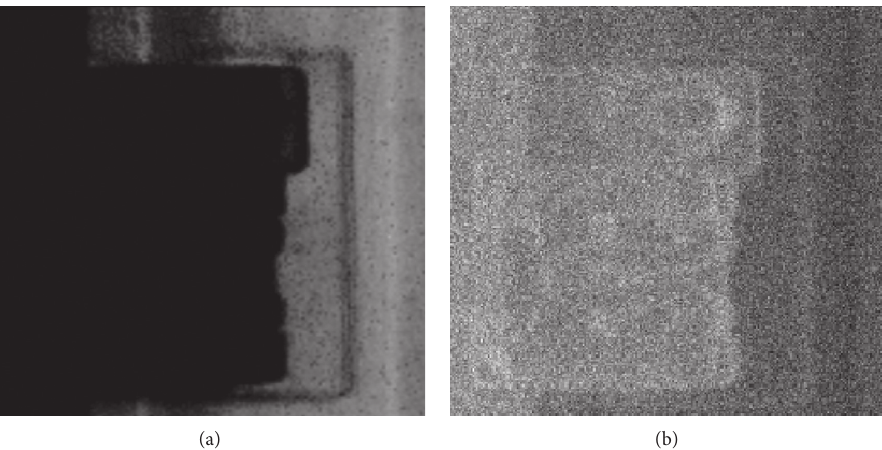
Figure 5: Image feature reconstruction of track fasteners. (a) Image feature reconstruction extracted by AE. (b) Image feature recon- struction extracted by